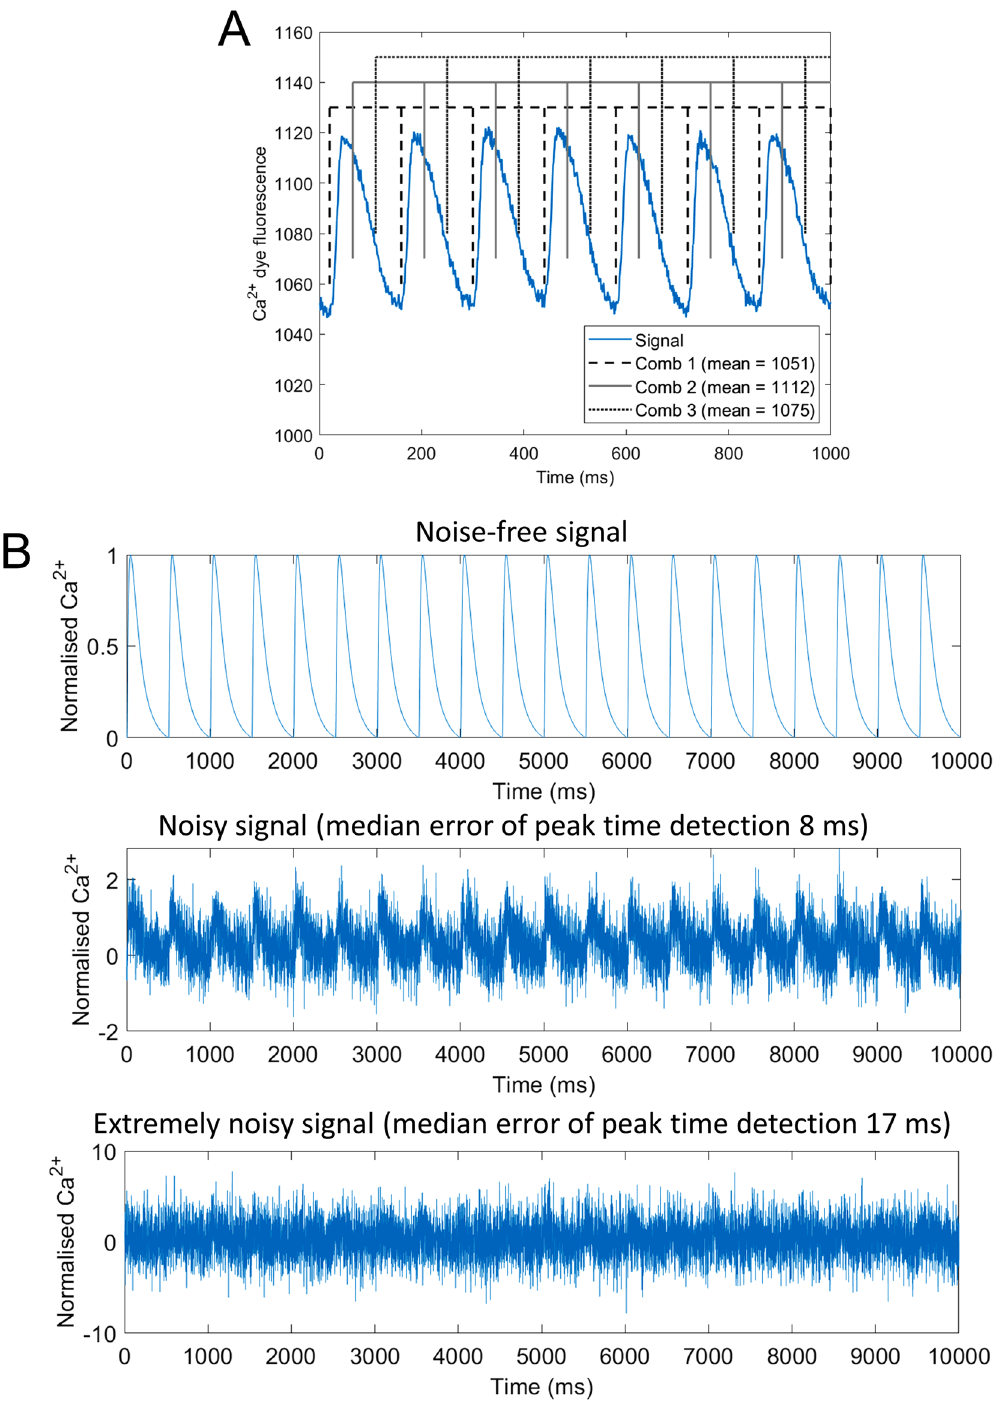
Figure 2. The comb algorithm and its noise-resistance. ( A ) Illustration of comb positioning in a recording of calcium transients in rat heart paced every 140 ms. Three distinct positions of comb are shown, with the average value under comb teeth being given in the legend. The dashed comb has the lowest average value, being the best comb position for extraction of signal minima. ( B ) An example of the trace of 20 calcium transients (generated using the computer model ToR-ORd 16 ) with no added noise (top), heavy noise (center), and an extremely high amount of noise added (bottom). COSMAS detected calcium transient peak times with a median error of only 8 ms for heavily noisy signal and only 17 ms in the extremely noisy signal, demonstrating the robustness of the algorithm to noise. Further quantitative data on noise-resistance versus the number of beats in a recording are given in Supplementary Figure